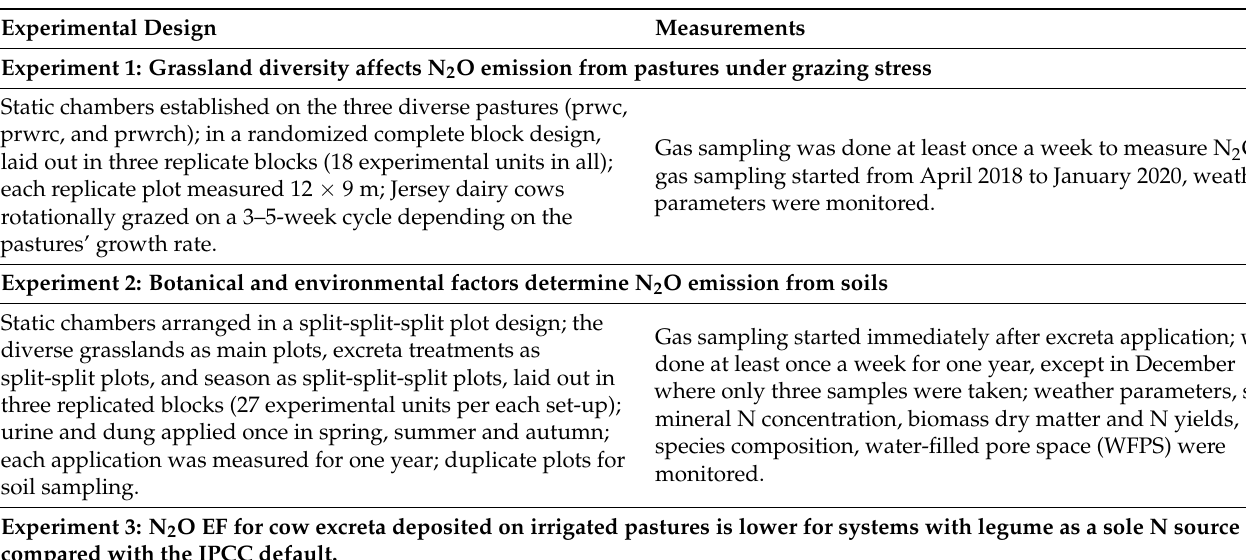
Table 1. Summary of the experimental designs and measurements.